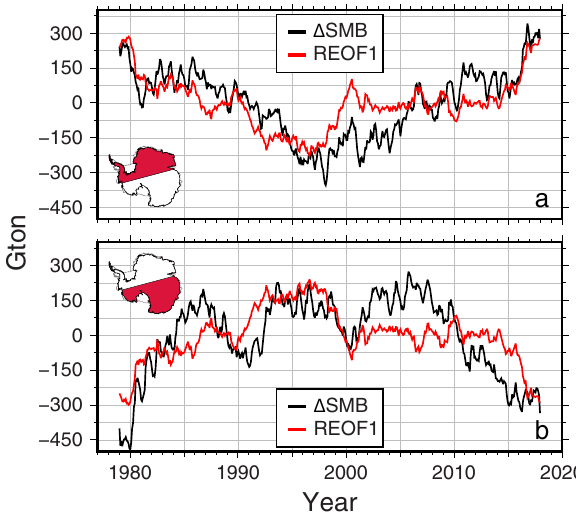
Figure 4. Comparison of (cid:31) SMB (black) and reconstructed (cid:31) SMB (red) for the first REOF mode over the Pacific Sector ( a ) and Atlantic-Indian Sector ( b ). Figures are created with Generic Mapping Tools (GMT-5.4.5, https ://gmt.soest .hawai i.edu/).